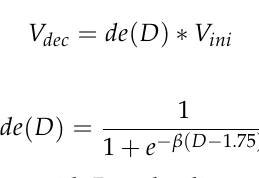
Figure 6. Speed adjustment between safety zones. To raise the working e ffi ciency when a customer is present in the deceleration zone, the proposed strategy is to move the mobile platform along the opposite direction a cer- tain distance, so that he/she would then be located at the normal zone to have a higher execution speed. As the aisle is in general very narrow and the robot arm also needs to be close to the shelf, only horizontal movement is taken, as shown in Figure 7. In Figure 7, with the mobile platform moved to leave a distance of d to change that between the cus- tomer and robot from 𝐷 (cid:2869) to 𝐷 (cid:2870) , the customer is now located at the normal zone (outside of the red line), instead of the original deceleration zone (between the green lines). Note that the length of d is limited to be about half of the moving range of the robot arm in the horizontal direction, as the robot arm still needs to have enough space to conduct the re- plenishment task.